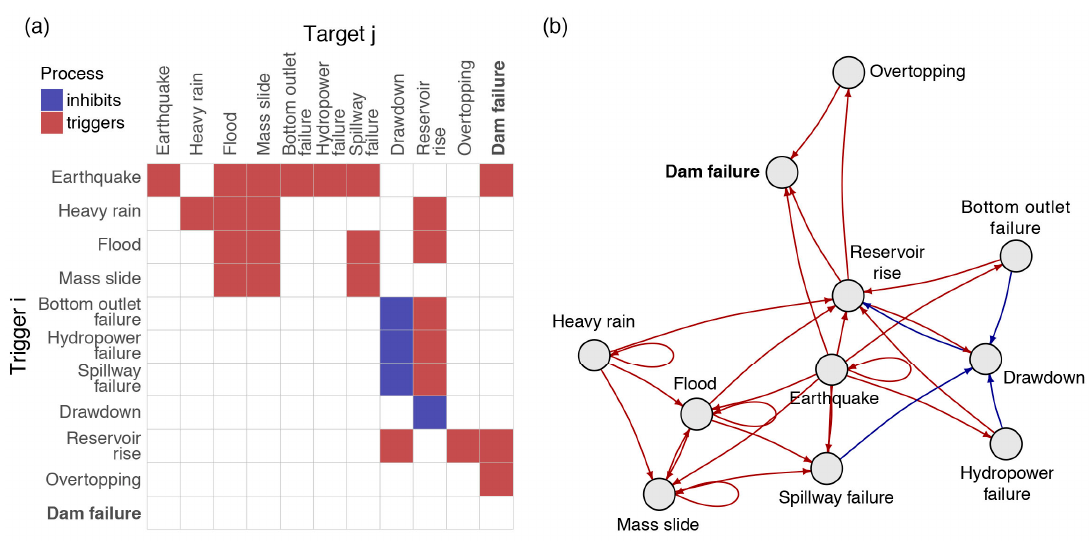
Figure 1. Illustration of how event interactions can lead to the catastrophic failure of a hydro-dam: ( a ) Interactions encoded in an adjacency matrix A following [4,22]; ( b ) Interactions described in a graph G.